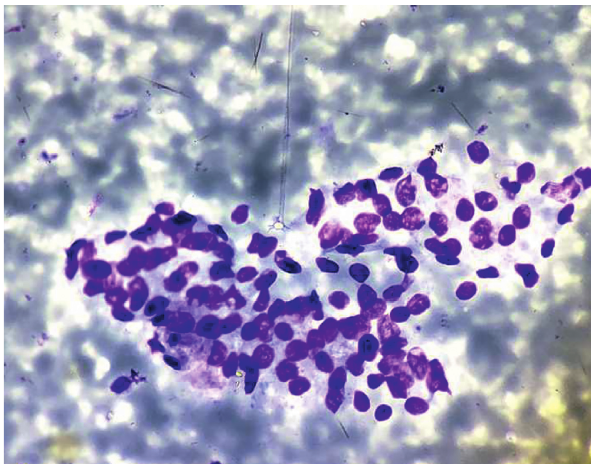
Figure 3: Fine-needle aspiration cytology from the nodule showing the cluster of benign-looking thyroid epithelial cells in the back- ground of RBCs (Giemsa stain,